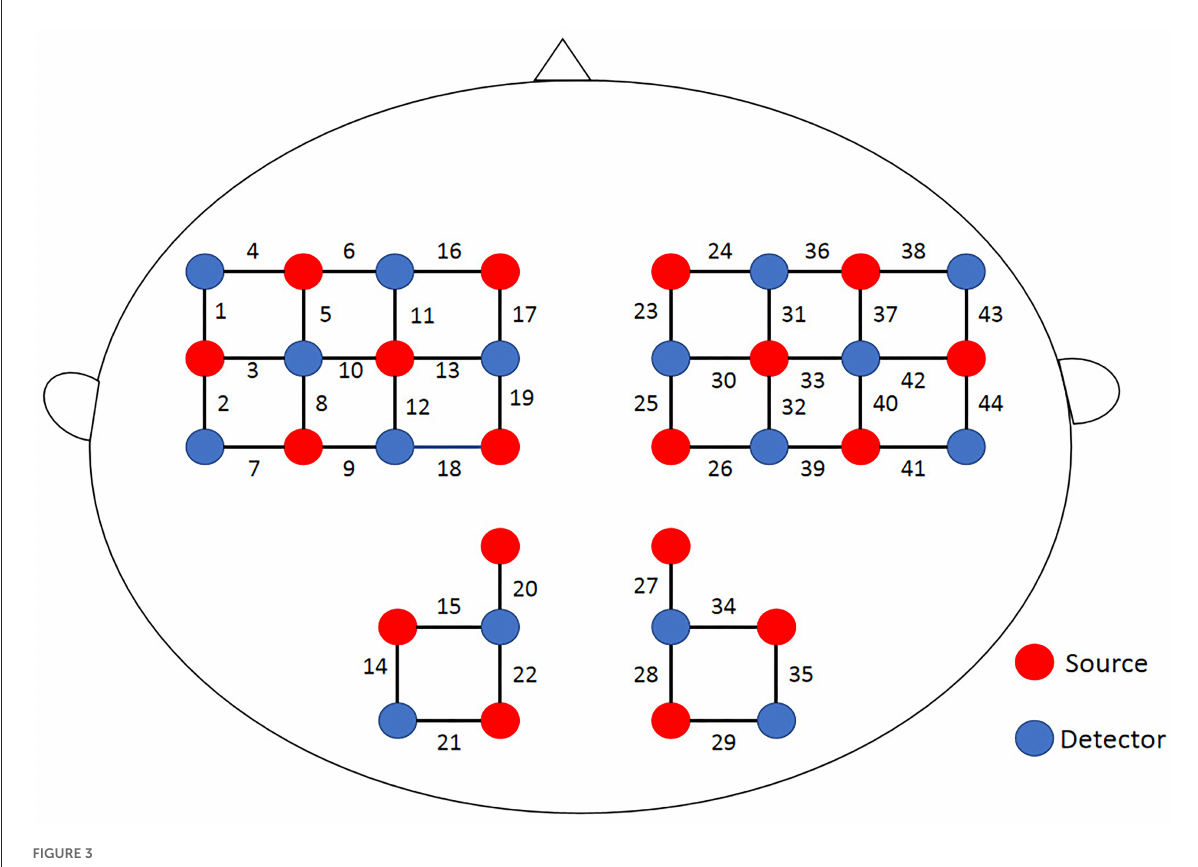
FIGURE3 Brain map of channel distribution.